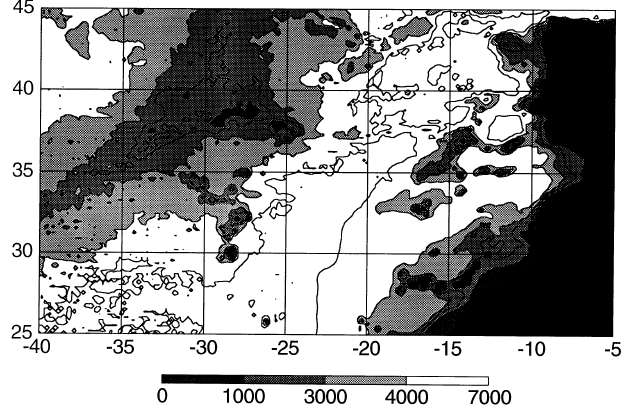
Fig. 11. Bathymetry of the Azores region. Contour intervals is